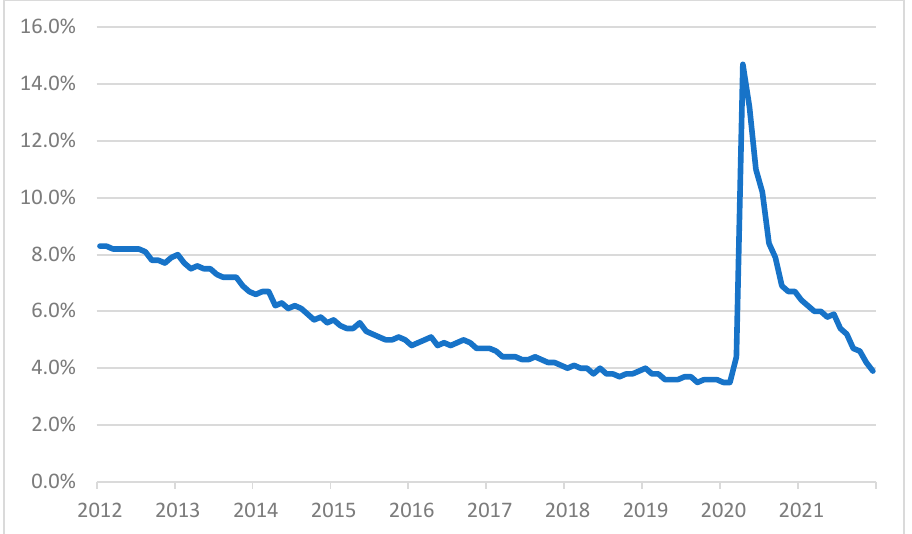
Figure 3. U.S. Unemployment rate, 2012–2021. Source: Created by the Authors.